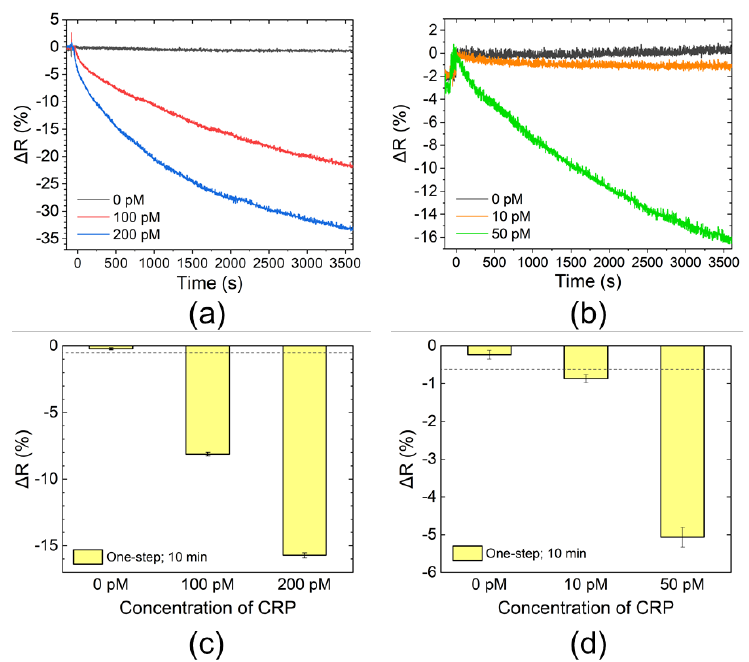
Figure 3. C-reactive protein (CRP) detection results using one-step method. Time course of changes in reflectance (ΔR) measured using waveguide-mode sensor for ( a ) higher and ( b ) lower concentration samples. Values of ΔR at 10 min for ( c ) higher and ( d ) lower concentration samples. Bars show mean values of 10 data points around 10 min presented in ( a , b ), respectively. Error bars are standard deviations (σ). Dashed lines show values of mean minus 3.3 σ of 0 pM sample (blank solution).